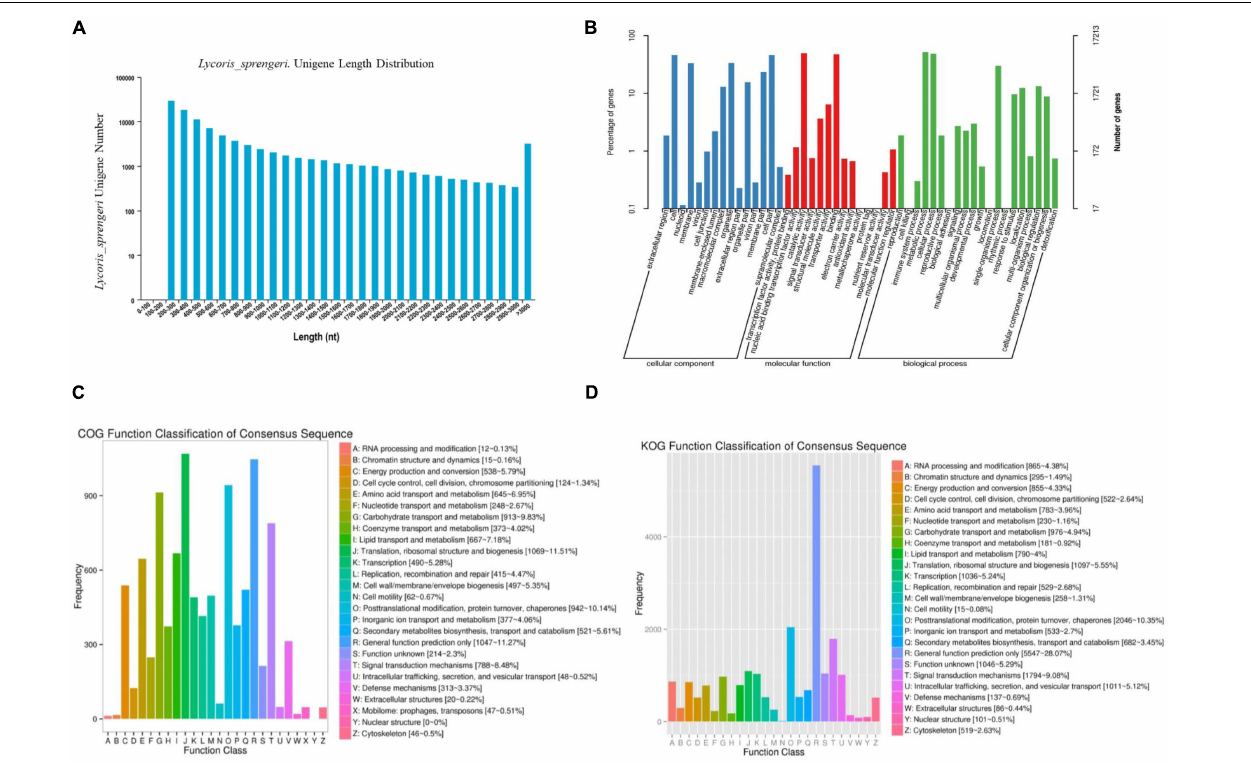
FIGURE 3 | An overview of the RNA sequencing (RNA-seq) data analysis in white and pink petals. (A) Unigene length distribution of sequencing reads and contigs in L. sprengeri RNA-seq. (B) Histogram representing Gene 02Ontology (GO) classification. GO categories, shown on the x -axis, were grouped into three main ontologies: biological process, cellular component, and molecular function. The right y -axis indicates the number of genes in each category, while the left y -axis indicates the percentage of total genes in that category. The “all gene” indicates that unigenes were those assembled from reads from pink and white petals. (C) Histogram representing clusters of orthologous groups (COG) classification. A total of 33,456 unigenes were assigned to 24 categories in the COG classification. (D) Histogram representing the eggNOG classification. The y -axis “frequency” indicates the number of genes in a specific functional cluster. The right side of the legend shows a description of the 24 functional